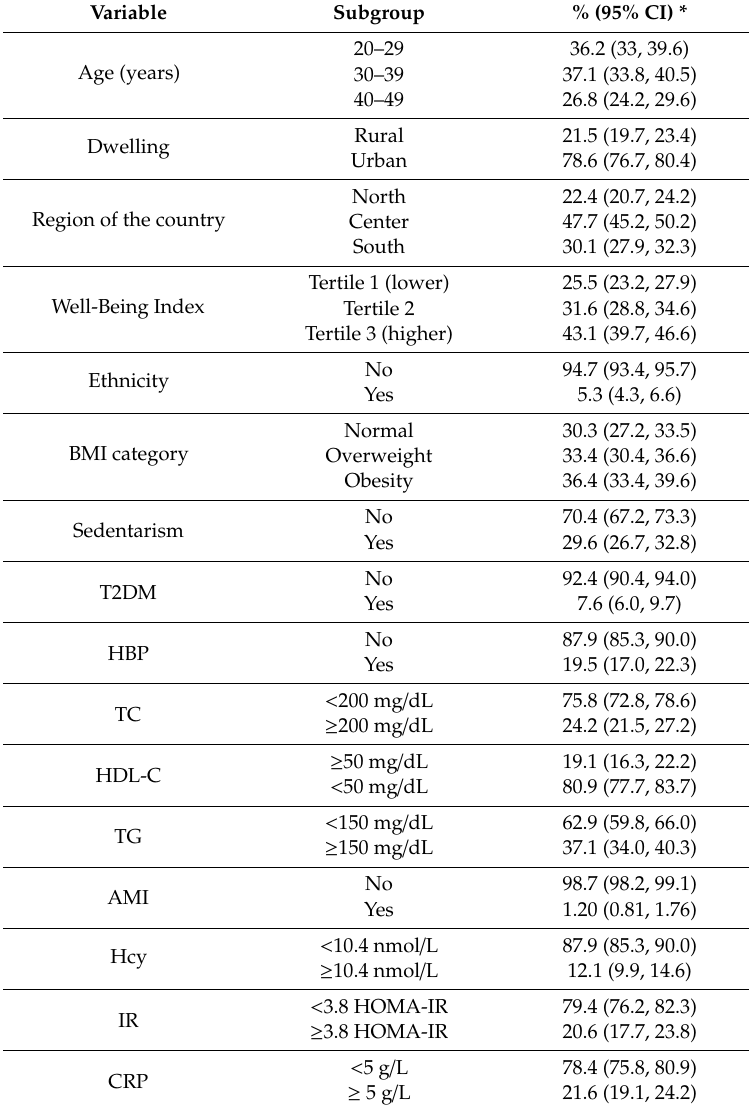
Table 1. Characteristics and distribution of the